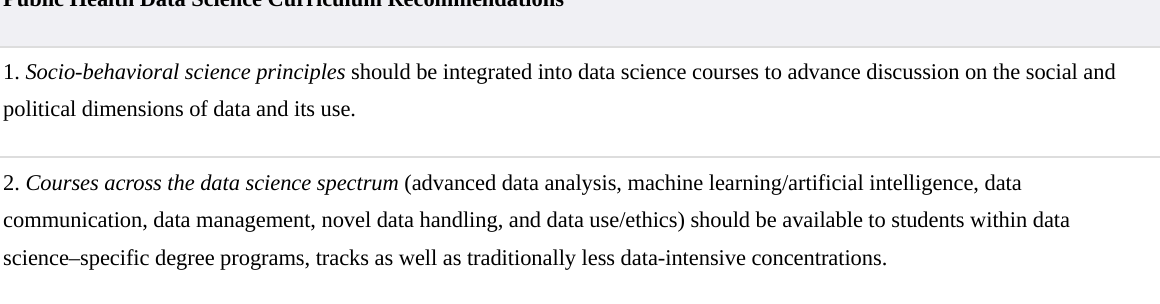
Table 2. Four-point formula to enhance public health data science opportunities for diverse groups beyond standard coursework